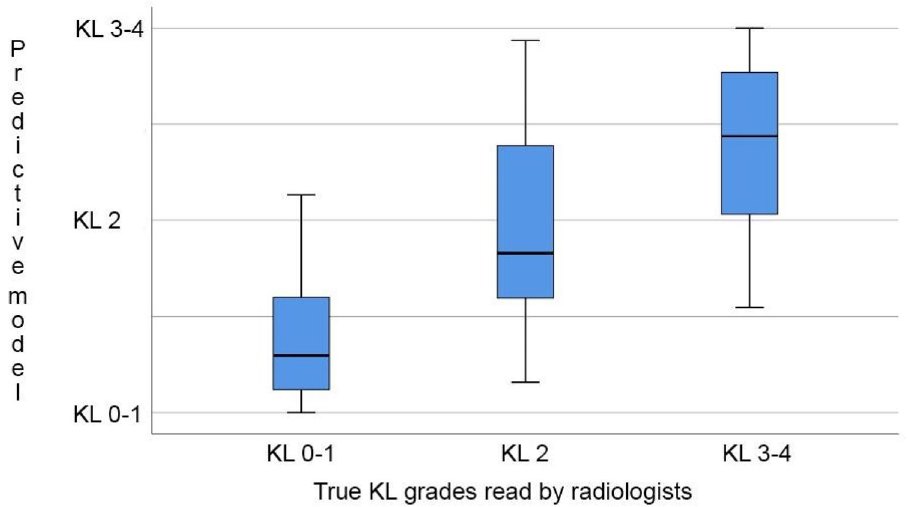
Figure 2. The boxplot describing the predicted KL grades (Y-axis) according to the predictive model within the radiologic KL grades (X-axis) in female subjects.